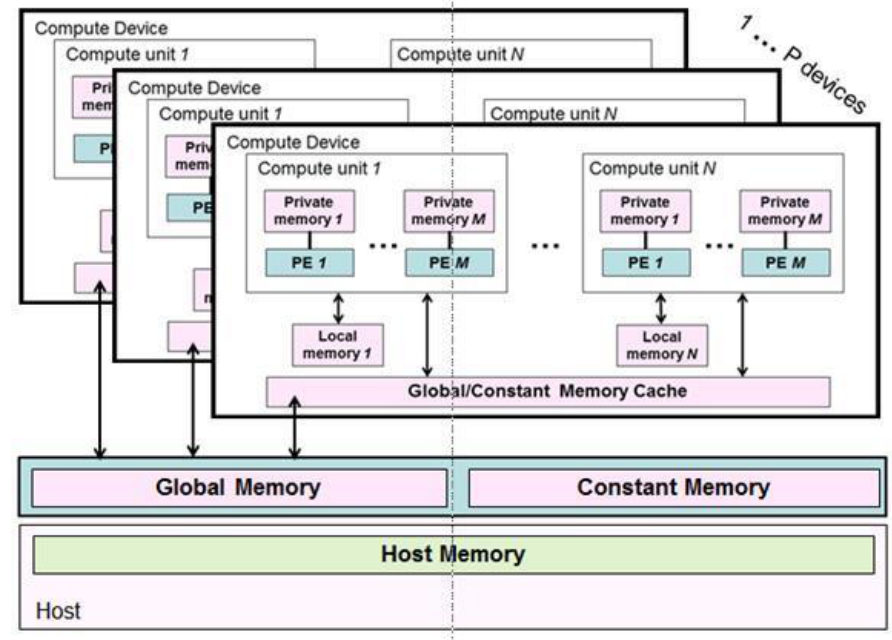
Figure 3. OpenCL memory model